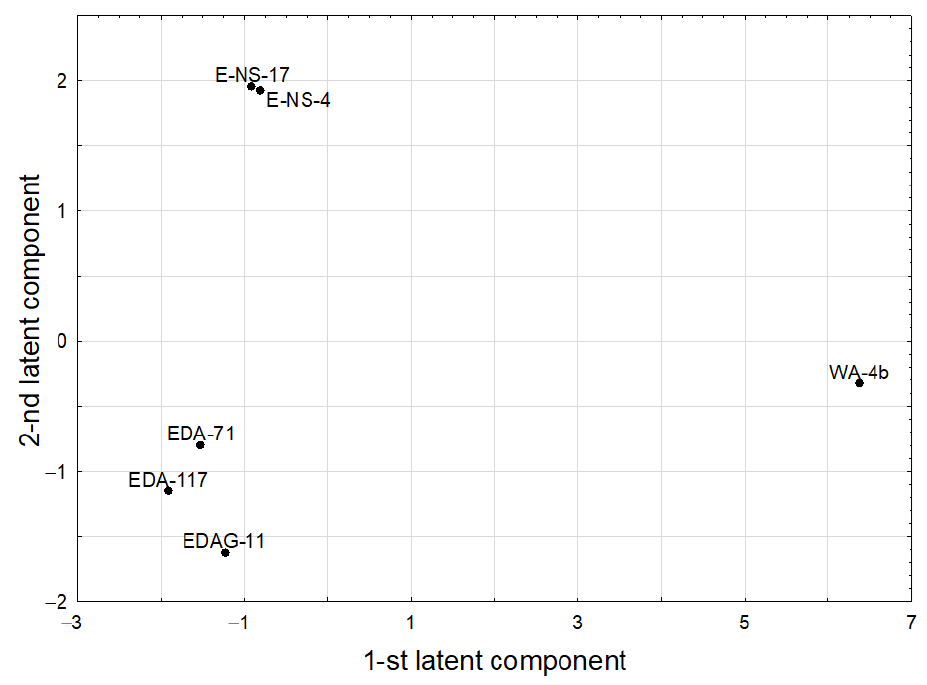
Figure 2. Score scatterplot of PLS model.